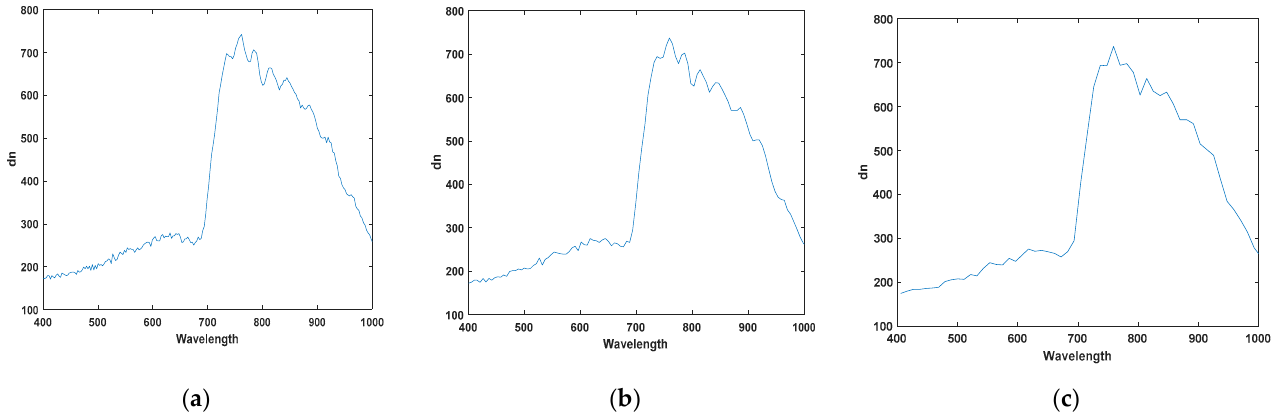
Figure 4. Spectral characteristics for each step of spectral binning ( a ) Full bands (224 bands) ( b ) 1/2 binning applied (112 bands), ( c ) 1/4 binning applied (56 bands).